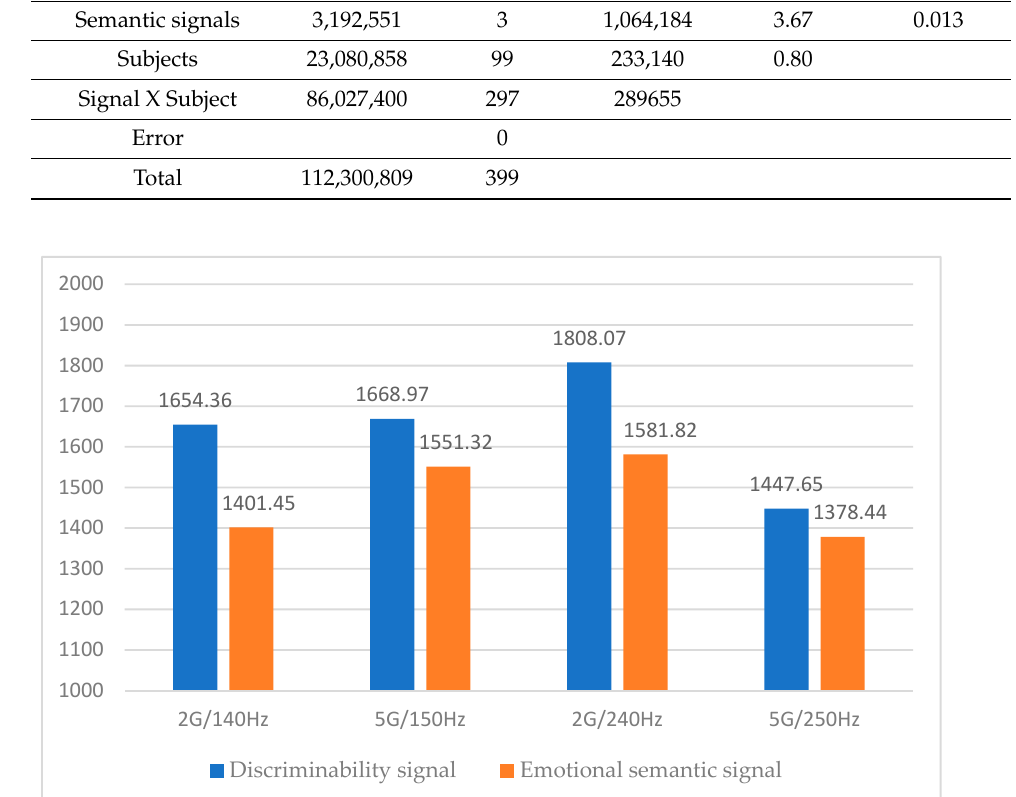
Figure 10. ANOVA results for two haptic signal groups.